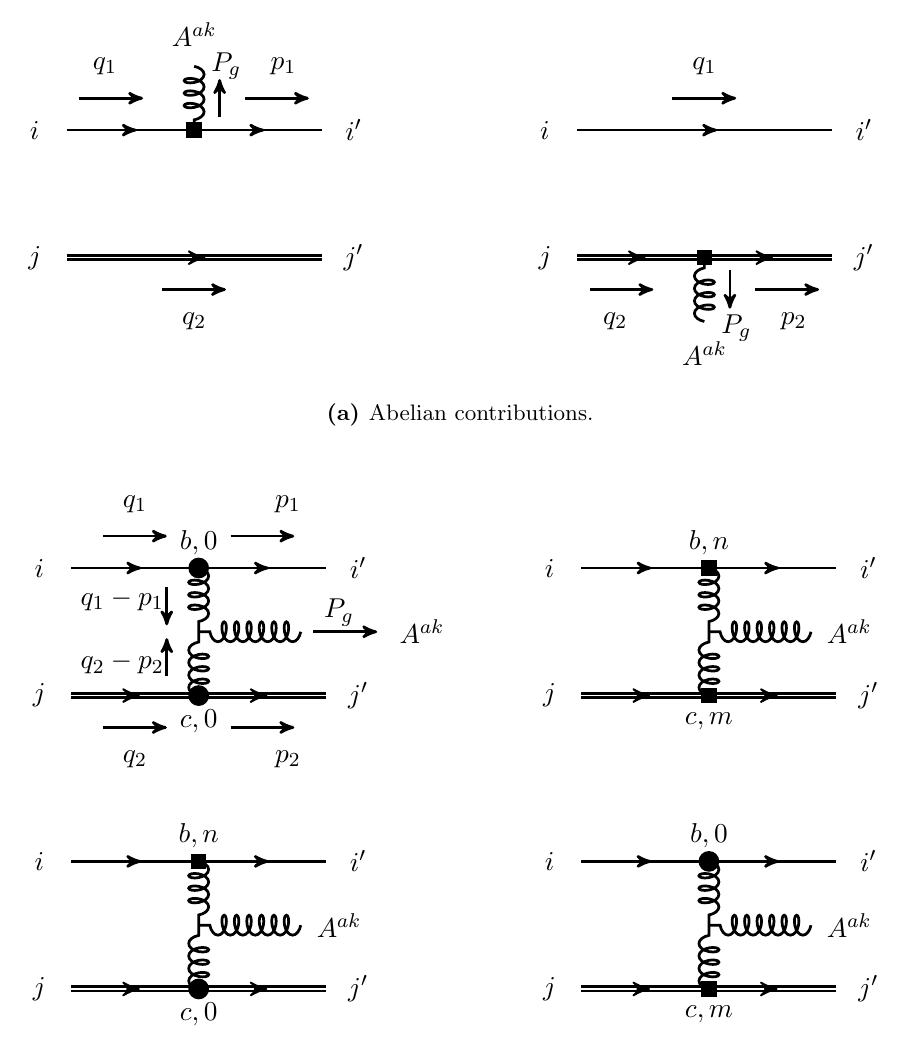
Figure 9. Gluon emission diagrams contributing to the radiative capture of a fermion-antifermion pair into a bound state. The fermion (cid:12)eld is depicted as a solid line, the antifermion (cid:12)eld (cid:31) as a double